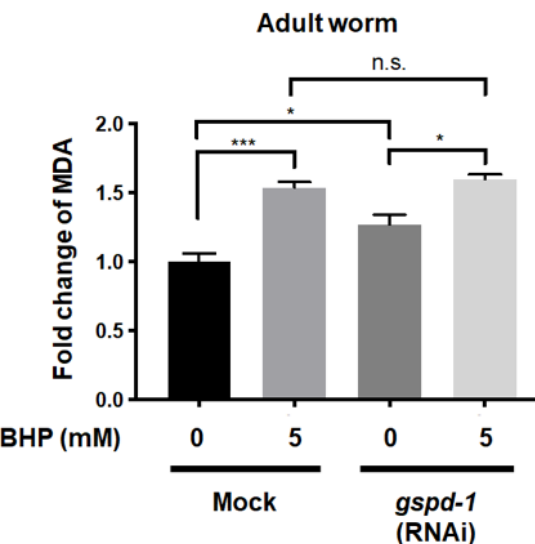
Figure 4. tBHP administration enhanced MDA levels in young adults of mock and gspd-1 -knockdown C. elegans . The lipid peroxidation level of mock and gspd-1 -knockdown C. elegans with or without 5 mM